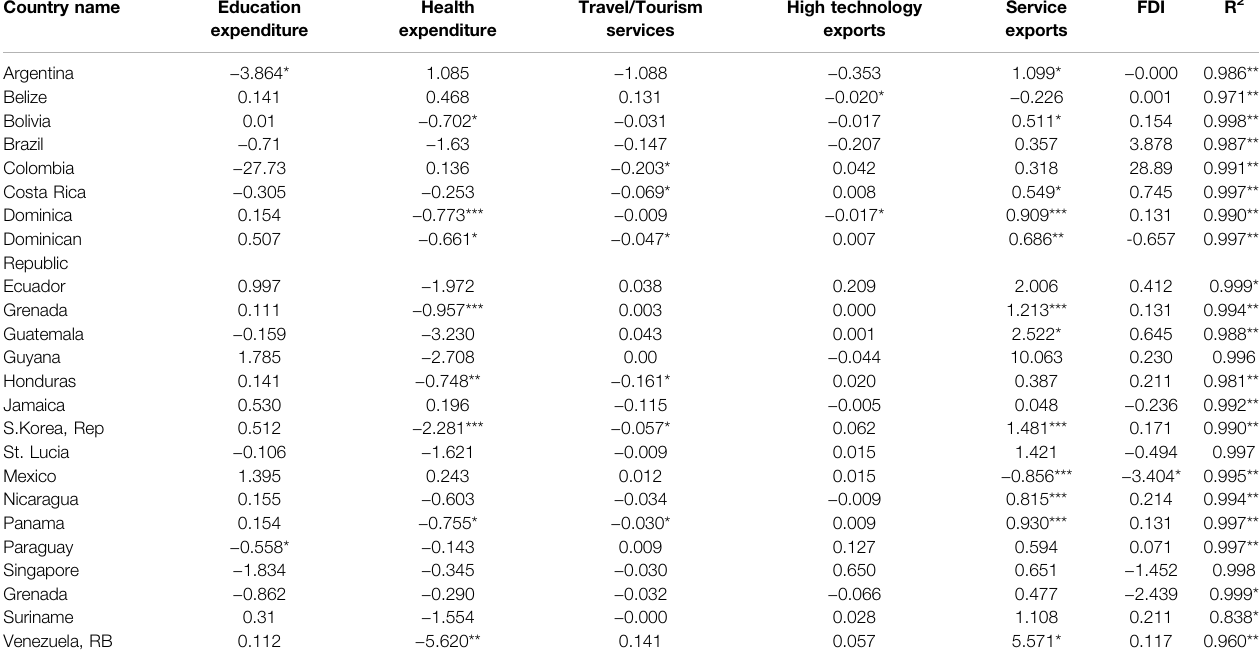
TABLE 3 | Regression model for Latin American and other